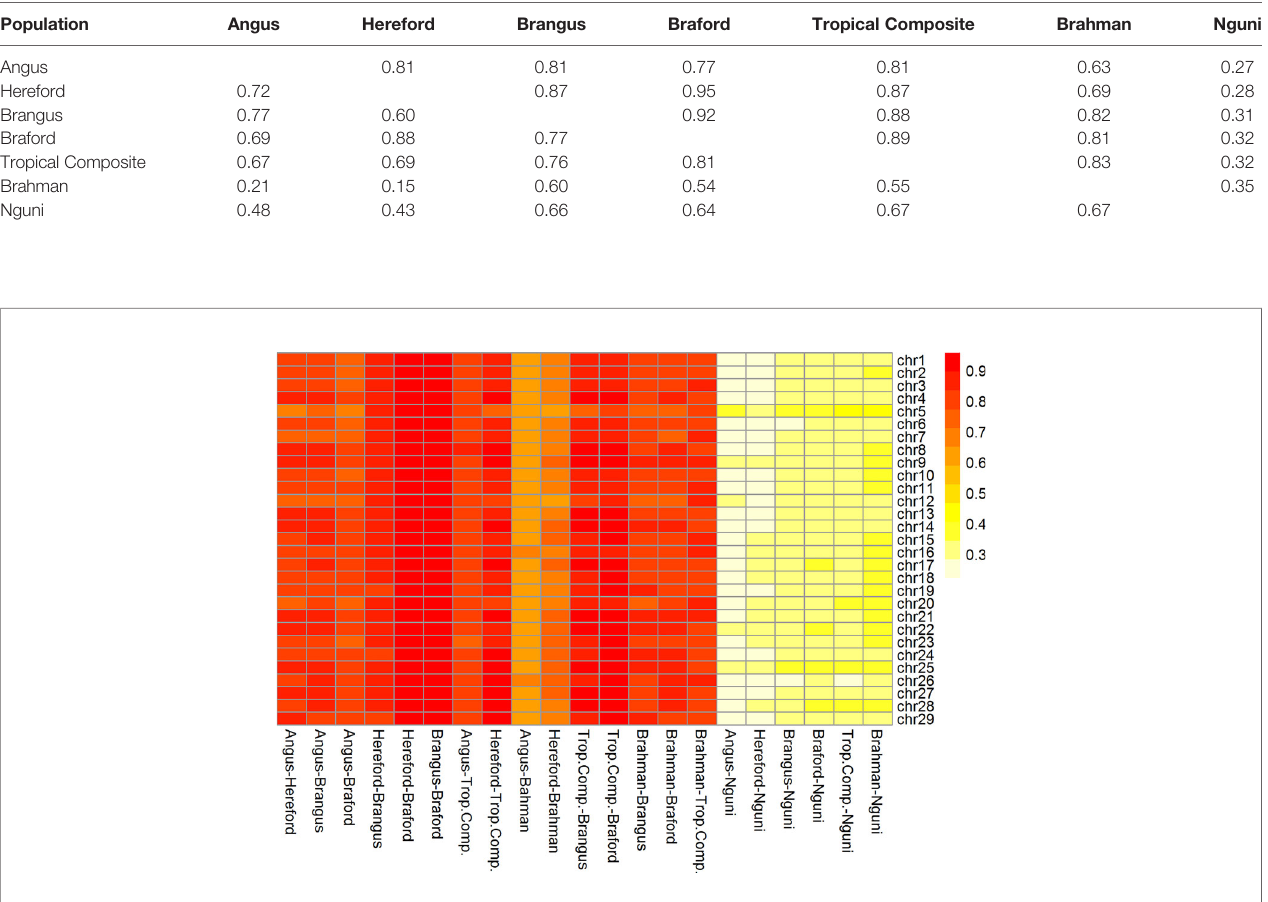
FIGURE 3 | Heatmap of correlation of phase between adjacent markers among breeds and chromosomes (332k panel by chromosome).